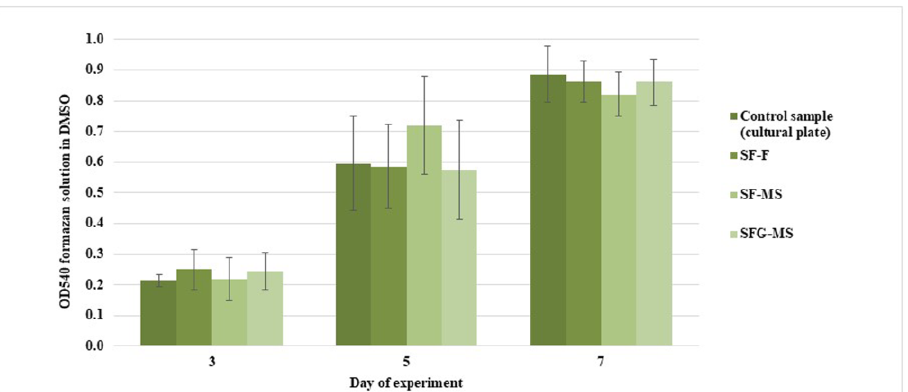
Figure 4. MTT assay on days 3, 5, and 7. The standard deviation values for 5 measurements are indicated.